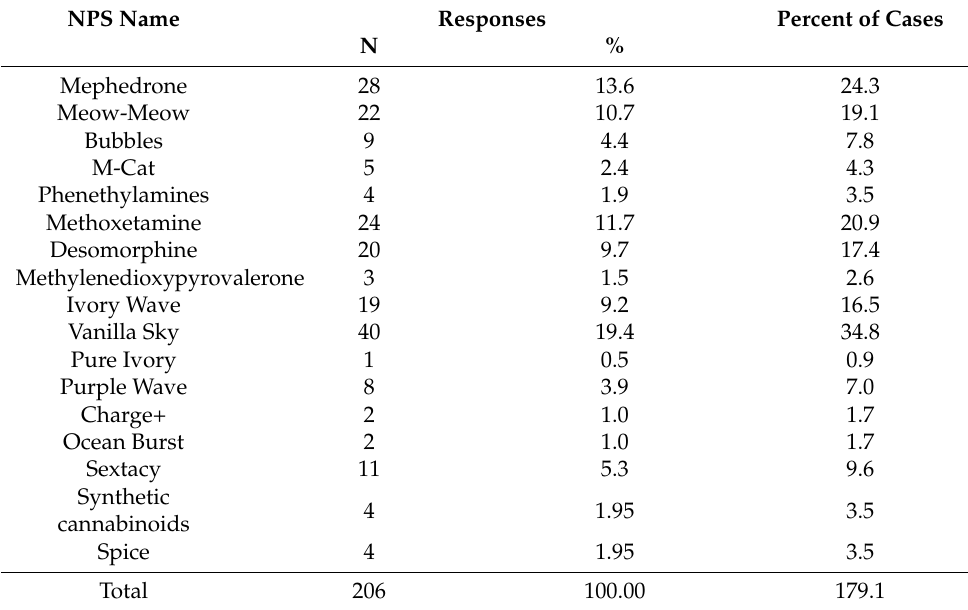
Table 3. Recognition of NPS names among future HCPs in